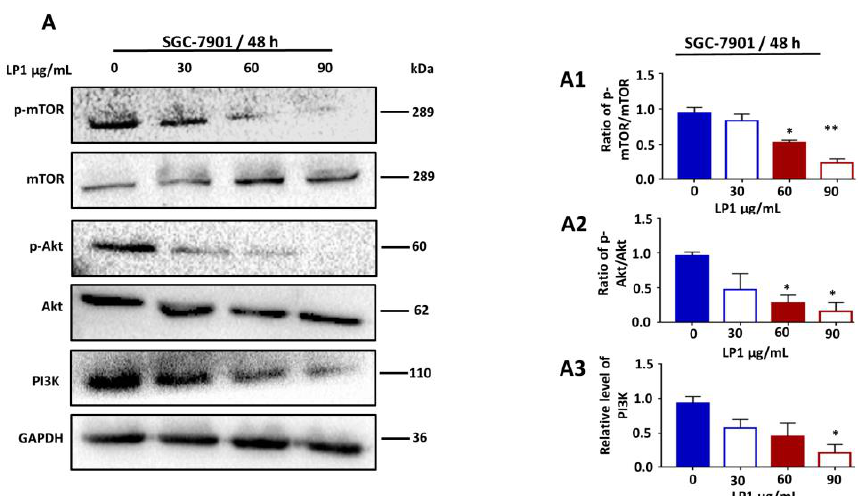
Figure 6. Inhibition of PI3K/Akt/mTOR pathway in SGC-7901 cells by LP1. ( A ) The expression levels of p-mTOR, mTOR, p-Akt, Akt and PI3K proteins were analyzed by western blotting assay. SGC-7901 cells were treated with various concentrations of LP1 (0, 30, 60, 90 µg/mL) for 48 h, GAPDH was used as an internal control. Data are expressed as means ± SD of three independent experiments. ( A1 – A3 ) Western blots were quantified by densitometry, results are expressed as mean ± SD and * p < 0.05, ** p < 0.01) of three independent experiments.